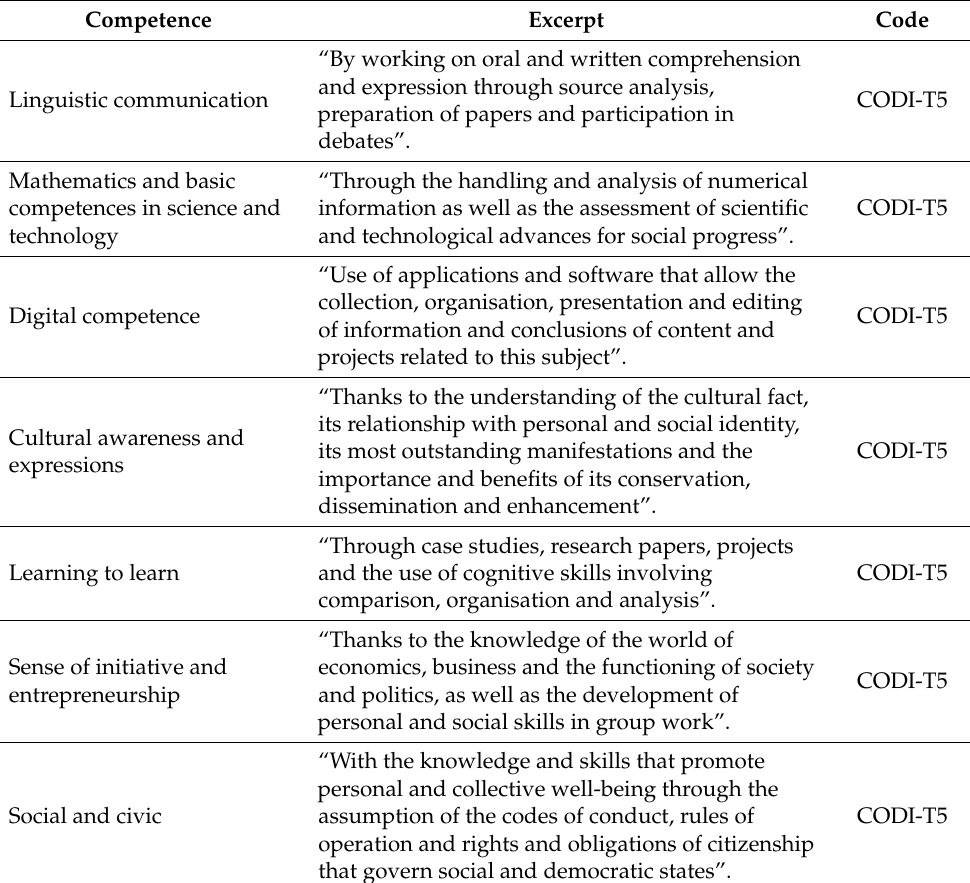
Table 5. Selection of excerpts on the topic contribution of the subject of Geography and History to the learning of competences, according to the Orden de 14 de julio de 2016